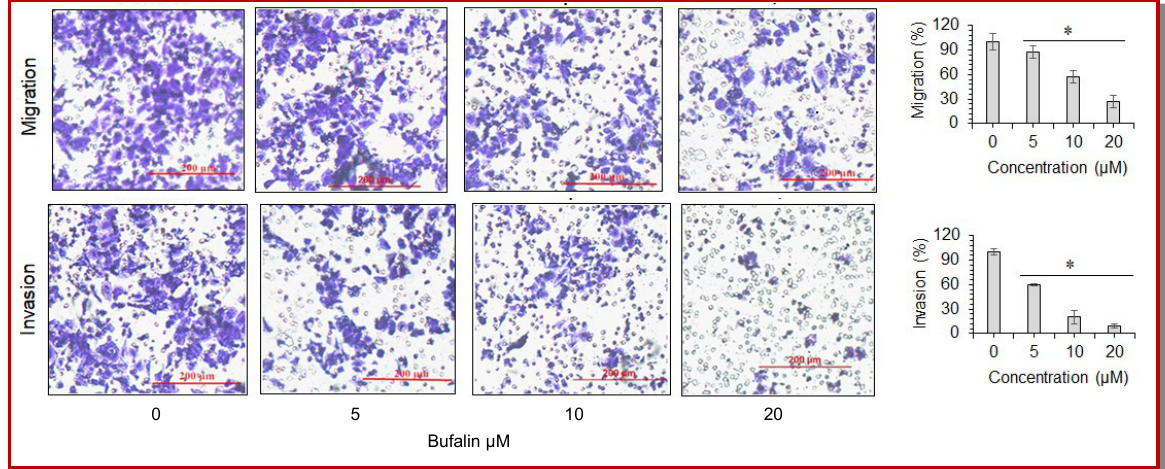
Figure 3: Bufalin treated gastric cancer cells display significantly lower migration and invasion. Analysis of migration and inva- sion of MGC-803 cancer cells through transwell assays incubated without or with 5, 10 or 20 µM bufalin at 37 º C for 48 hours. The experiments were performed in three biological replicate and the results are shown as mean ± SD (*P < 0.05)